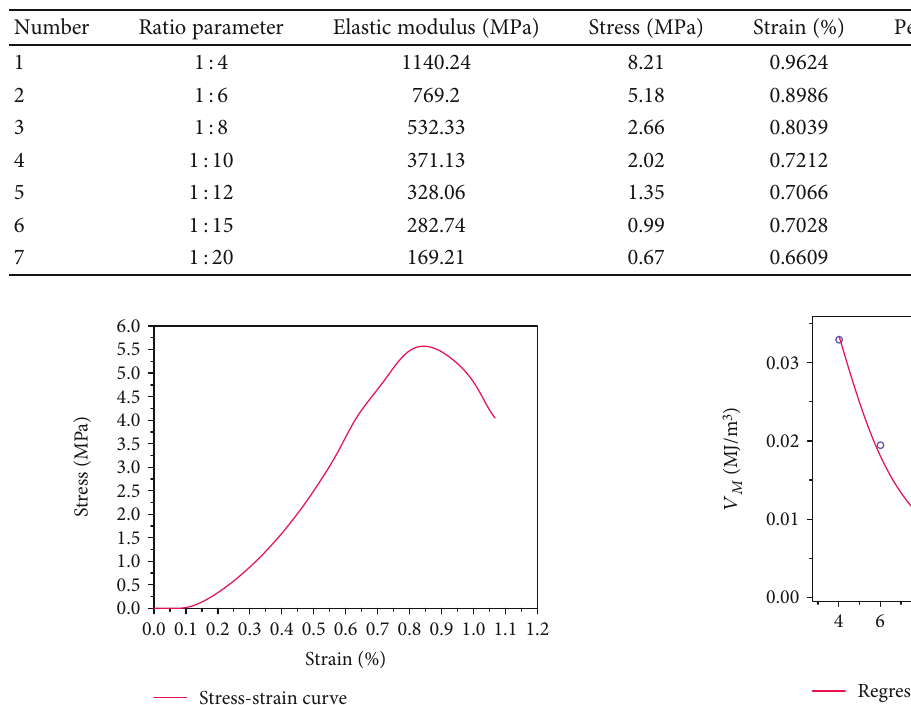
Table 2: The experimental results and the value of k under di ff erent ratios of cemented back fi ll.